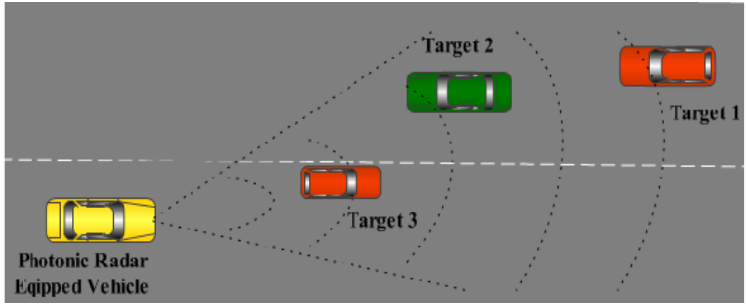
Figure 1. General diagram of tracking of multiple targets using photonic radars in autonomous vehicles [18].